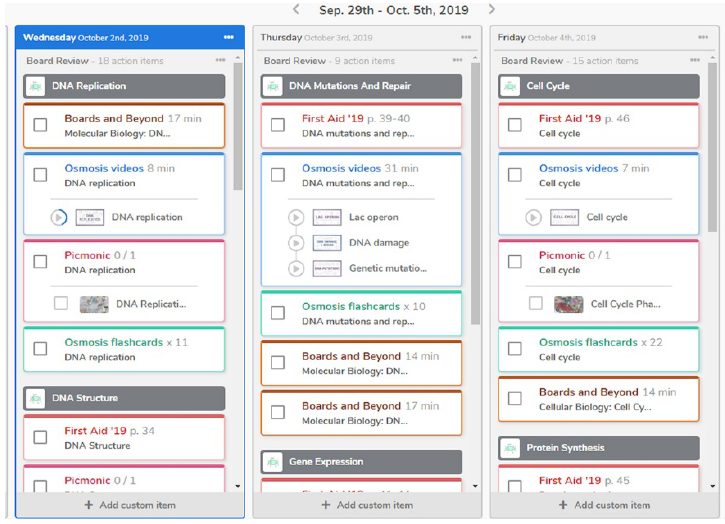
Figure 1 Screenshot of mock calendar created to track and organize a graduating medical student who is studying for board exams, with a timeline of October through May